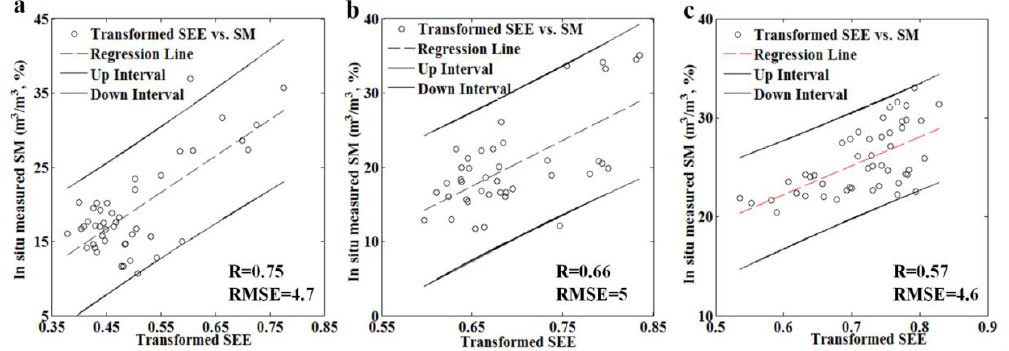
Figure 4. SM-SEE scatter plots, linear regression lines and associated prediction intervalsfor soft data. ( a – c ) correspond to 30 May 2012, 24 June 2012, and 10 July 2012, respectively. The dashed lines represent the regression line between the transformed SEE and in situ measurements. The solid lines indicate the prediction interval for 𝑆𝑀 confidence level of 95%, where 𝑇𝑟𝑎𝑛𝑠𝑓𝑜𝑟𝑚𝑒𝑑 𝑆𝐸𝐸 = 𝑐𝑜𝑠 −1 (1 − 2𝑆𝐸𝐸 0.5 ) /𝜋 . R represents the correlation coefficient between the transformed SEE and the in situ